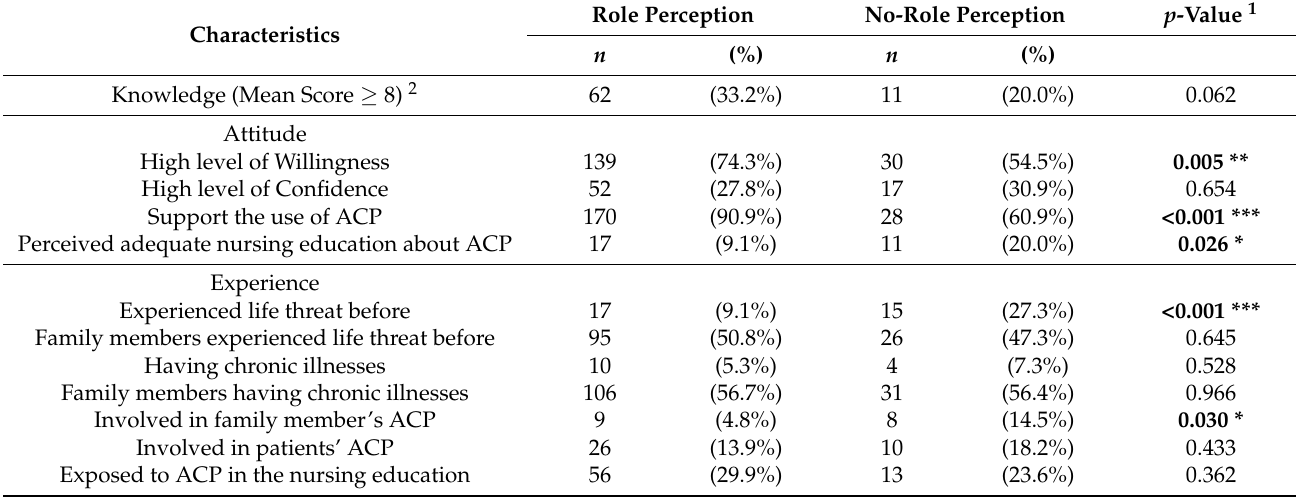
Table 2. Associations between participants’ role perception and their knowledge, attitude, and experience.